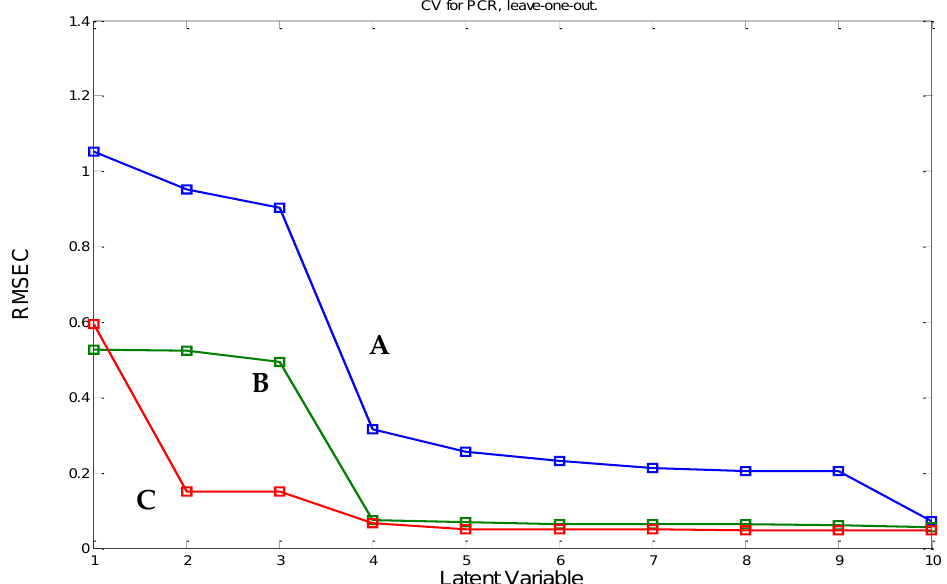
Figure 3. The root mean square error of the calibration (RMSEC) plot of the results of the cross- validation of the training set in the PCR model of (A) FRV, (B) Impurity-1, and (C) Impurity-2.